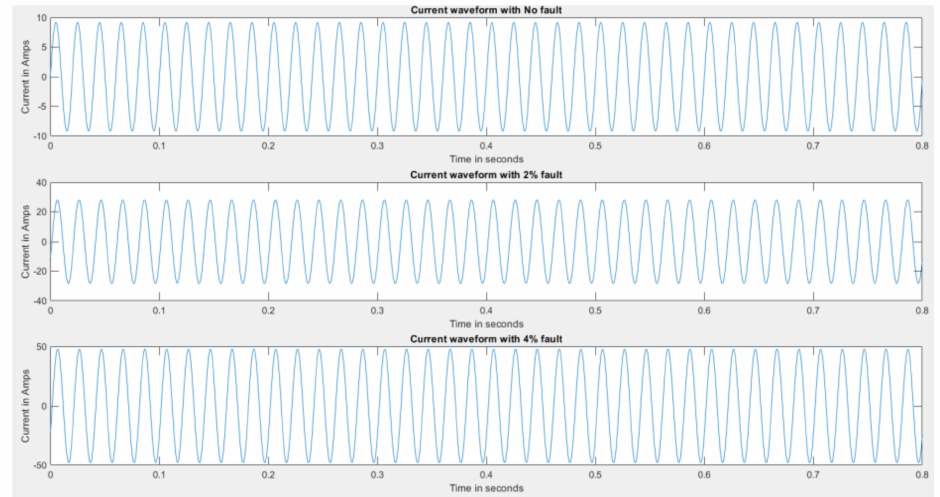
Figure 13. Internal faults with energization for different percentages of winding